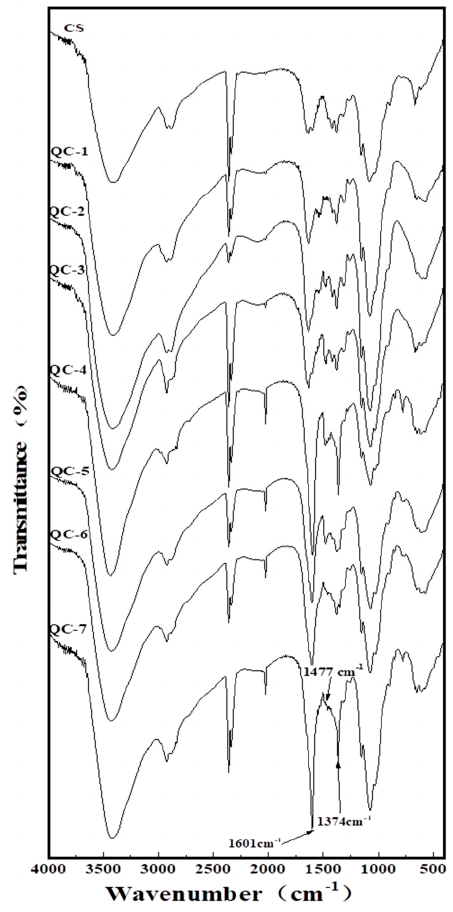
Figure 1. Fourier-transform infrared (FTIR) spectra of chitosan and QCs.